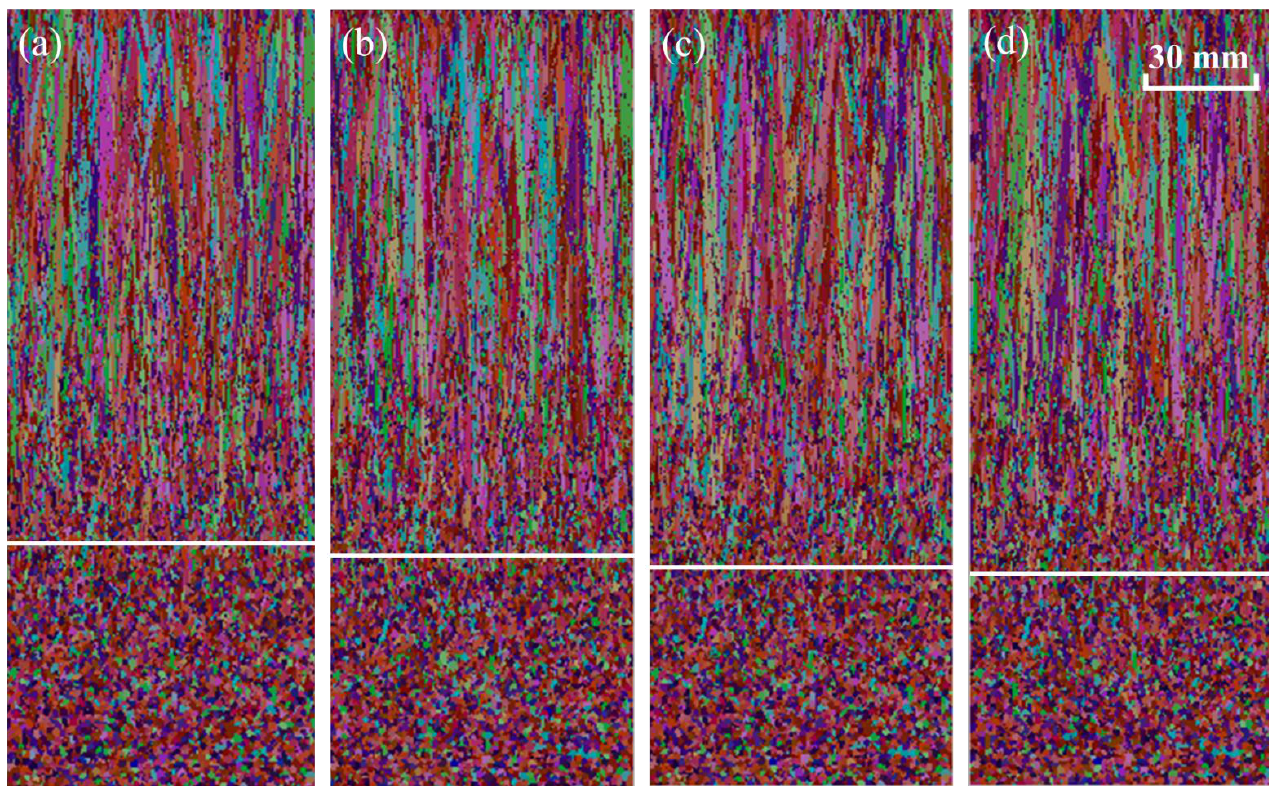
Figure 6. Simulated solidification structures under different casting speeds: ( a ) 0.45 m·min −1 ; ( b ) 0.45 m·min −1 ; ( c ) 0.50 m·min −1 ; ( d ) 0.50 m·min −1 . (Different colors in figure represent grain orientation)